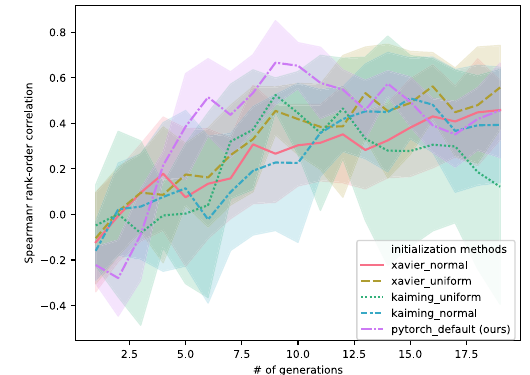
Fig. 4 The Spearman correlation coefficient for different initialization method on